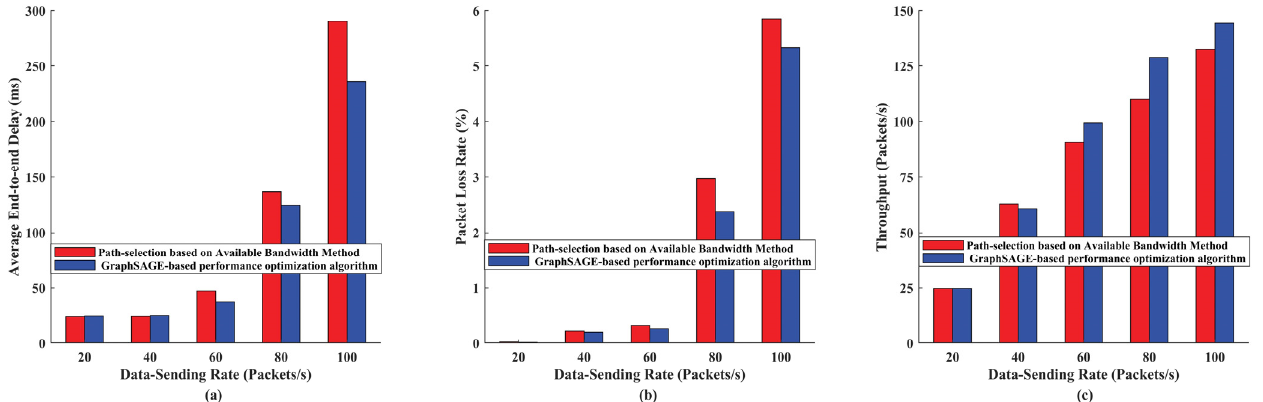
Figure 6. ( a ) Average end-to-end delay at di ff erent data sending rates. ( b ) Packet loss rate at di ff erent data sending rates. ( c ) Throughput at di ff erent data sending rates.